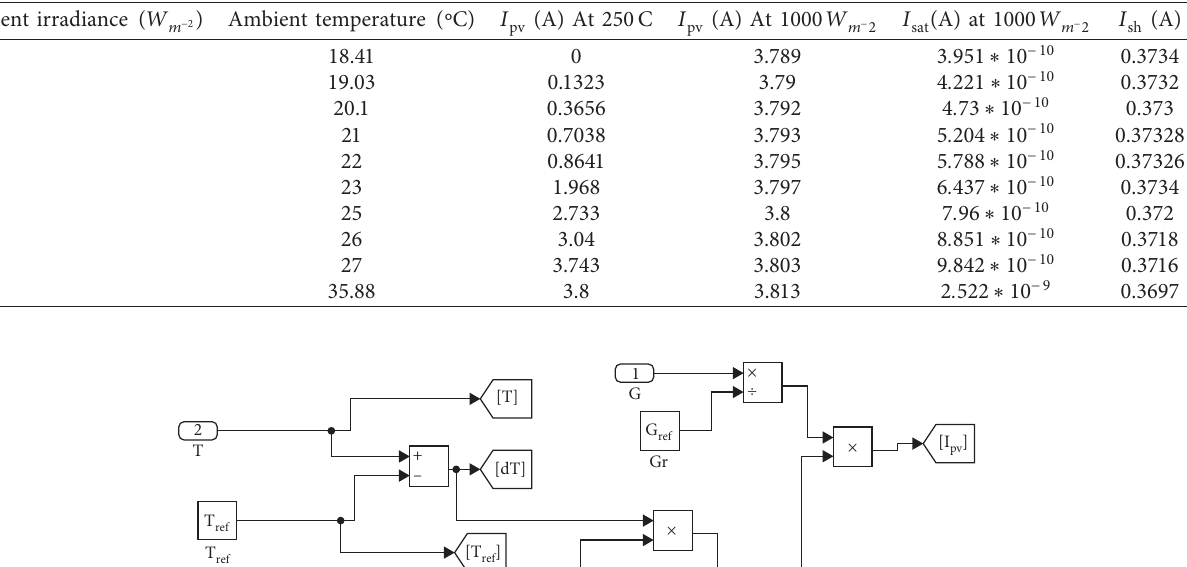
Table 3: Observations and computed values at the remote seismic node.